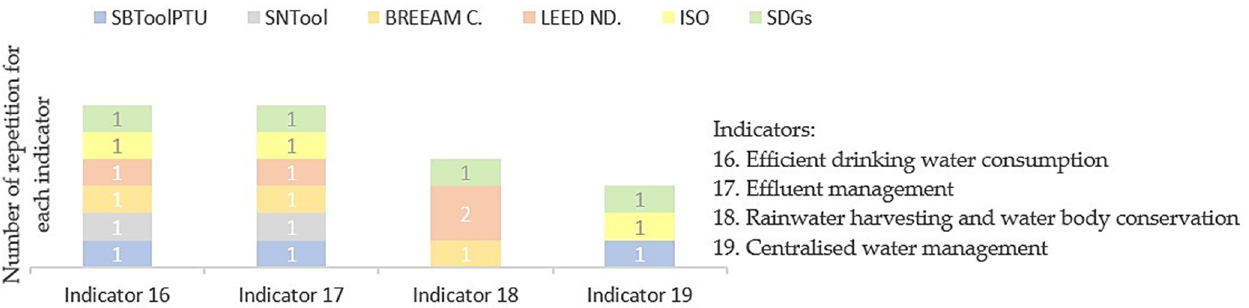
Figure 5. Frequency distribution of each indicator, relevant to the category of water-saving measures in SBTool PT _Urban (2018), SNTool Min (2020), BREEAM-C (2012), LEED-ND (2018), ISO 37120, and SDGs.